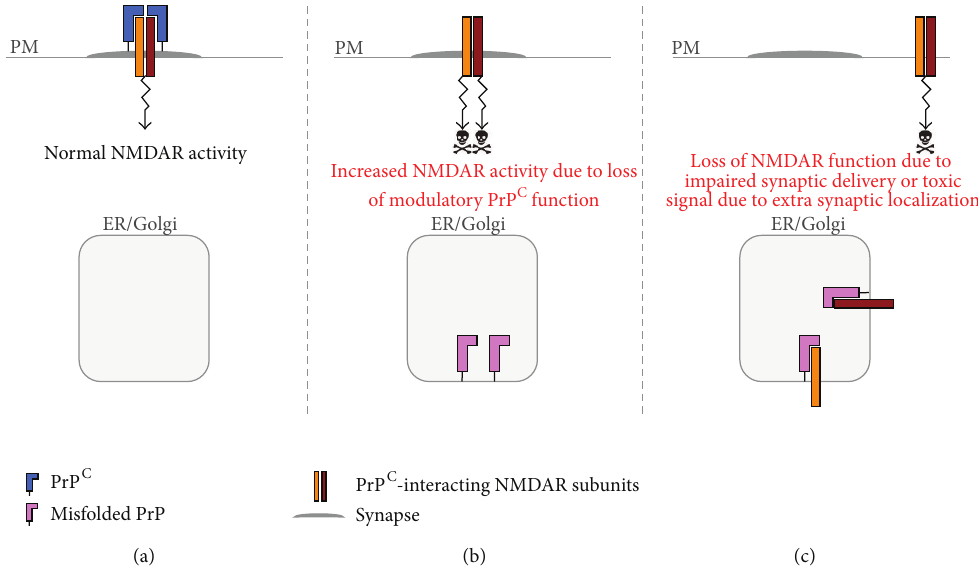
Figure 4: A role for intracellular PrP retention in NMDAR dysfunction. (a) PrP C on the plasma membrane (PM) attenuates NMDAR activity by associating with the NR2D subunit. (b) Owing to PrP C misfolding in transport organelles (ER/Golgi), PrP C is retained intracellularly. This results in increased NMDAR activation, potentially triggering neurotoxicity. (c) Intracellular retention of misfolded PrP C with NR2D and NR1 subunits results in impaired delivery of NMDARs to the cell surface or their abnormal targeting to extrasynaptic sites, leading to loss of NMDAR function and/or activation of neurotoxic